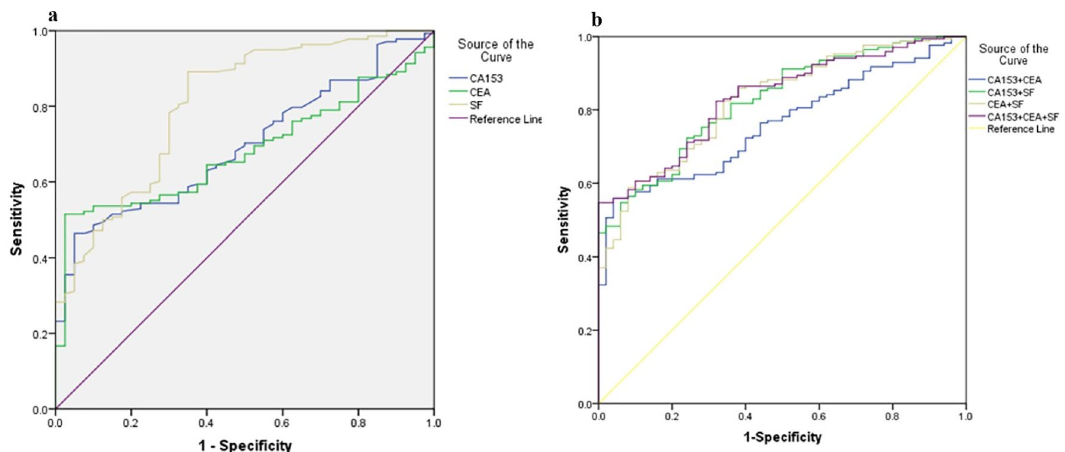
Figure. 3. The ROC curve of single and combined detection in the diagnosis of malignant canine mammary gland tumor. (a) The ROC curves of single detection of CA15-3, CEA, and SF. (b) The ROC curves of combined detection of CA153 + CEA, CA135 + SF, CEA + SF, and CA153 + CAE + SF.